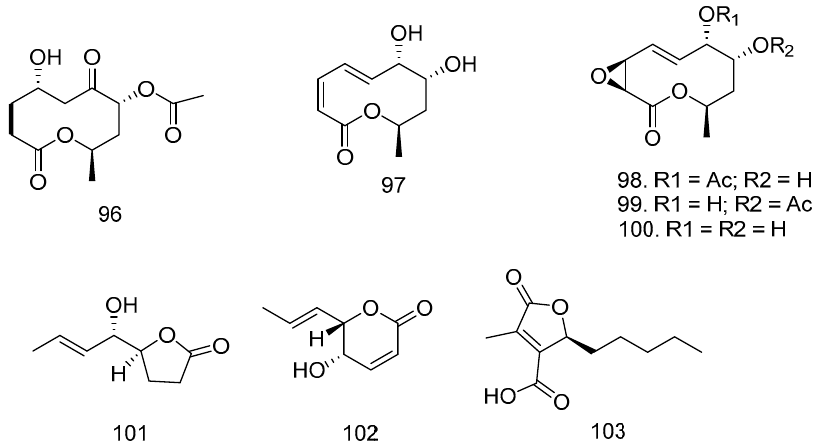
Figure 5. Lactone structures isolated from Meliaceae-derived fungi.